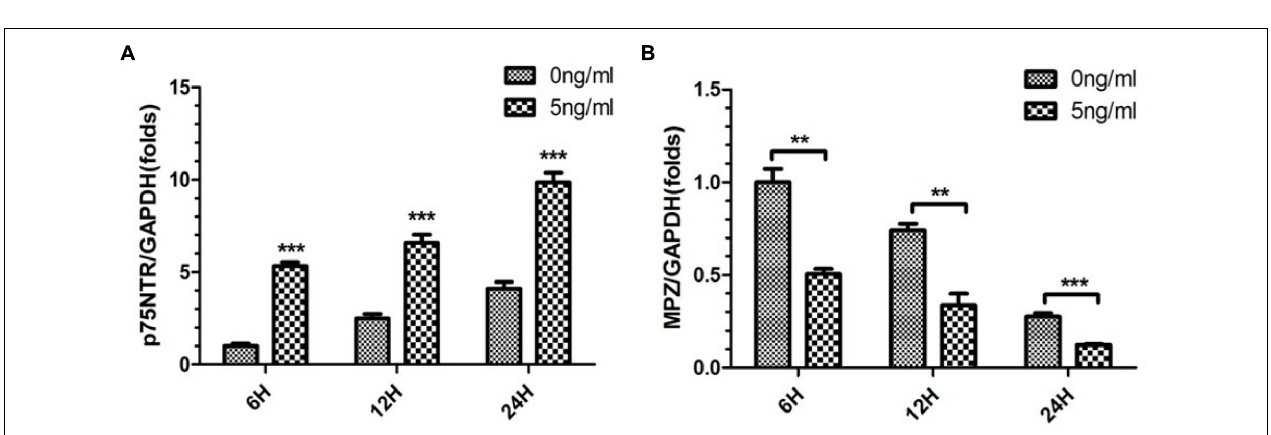
FIGURE 2 | Expression of p75NTR and MPZ in the in vitro WD model at 48 h. Immunofluorescent staining of p75nNTR (A) and MPZ (B) , and western blotting to quantitatively analyze expression levels (C–E) in SCs with various concentrations of IL-1 β at 48 h. Results are means ± SE ( n = 3 per group) from independent experiments. ∗∗ p < 0.01.